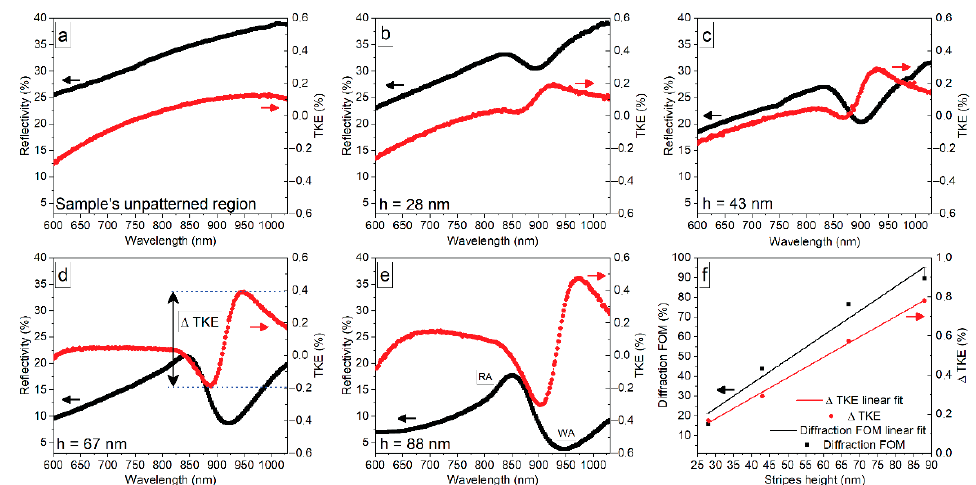
Figure 2. Reflectivity (black rectangles) and transversal Kerr effect (red circles) spectra for the ( a ) flat unpatterned region of the sample and the MPlCs with stripes’ heights of ( b ) 28, ( c ) 43, ( d ) 67, and ( e ) 88 nm, as well as ( f ) dependencies of the MPlCs diffraction FOM (black rectangles) and transversal Kerr effect modulation value Δ TKE (red circles) on the height of stripes. Insets on panel ( e ) indicate the positions of the Rayleigh (RA) and Wood (WA) anomalies. Solid lines in panel ( f ) indicate the linear fit and corresponding residuals of diffraction FOM (black) and TKE modulation value (red), respectively. The arrows on each panel point to the y -axis for the nearby dependencies.